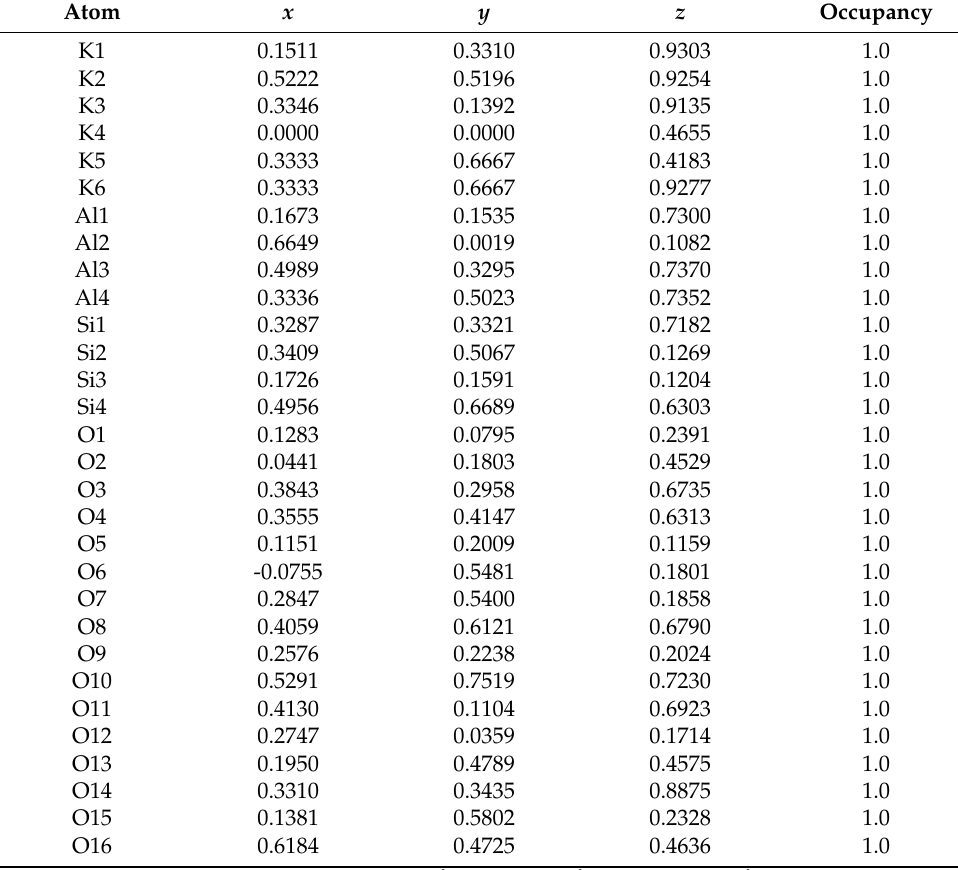
Table 4. The refined positions of all the atoms and the lattice parameters of